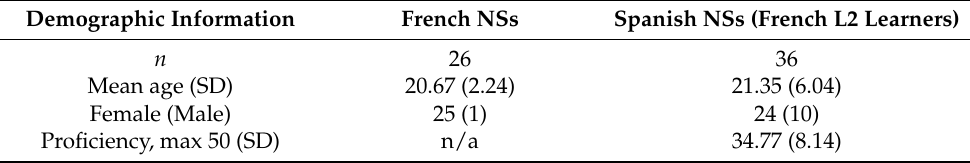
Table 2. Demographic information for both participant